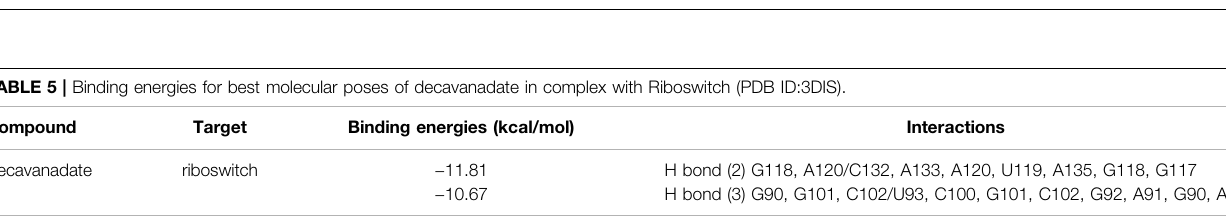
FIGURE 10 | Interaction of decavanadate with the riboswitch (3DIS) visualized with UCSF Chimera X program, (2021).